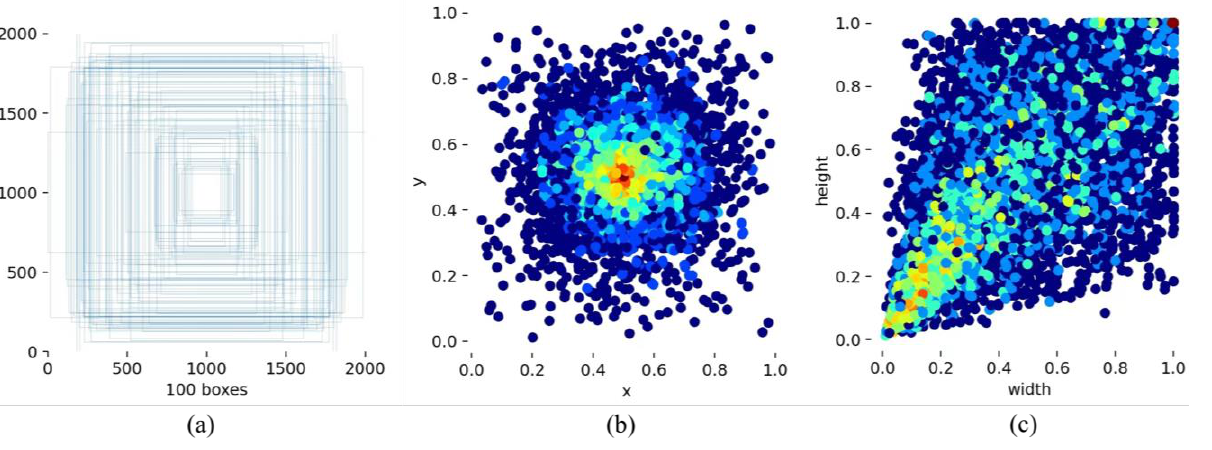
Table 3. Comparison of the Swin transformer backbone with the ResNet backbone.